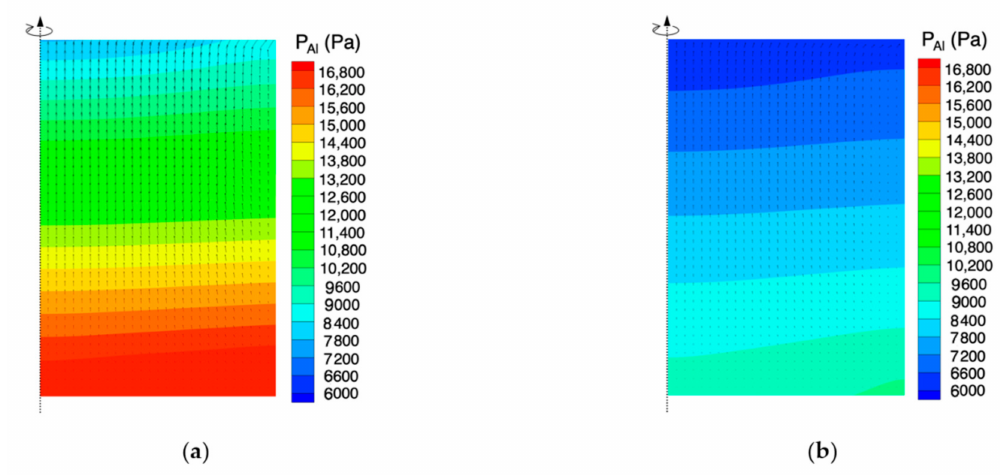
Figure 9. Mixed flow field together with Al vapor partial pressure in growth chamber at ∆ T = 130 ◦ C ( a ) and ∆ T = 80 ◦ C ( b